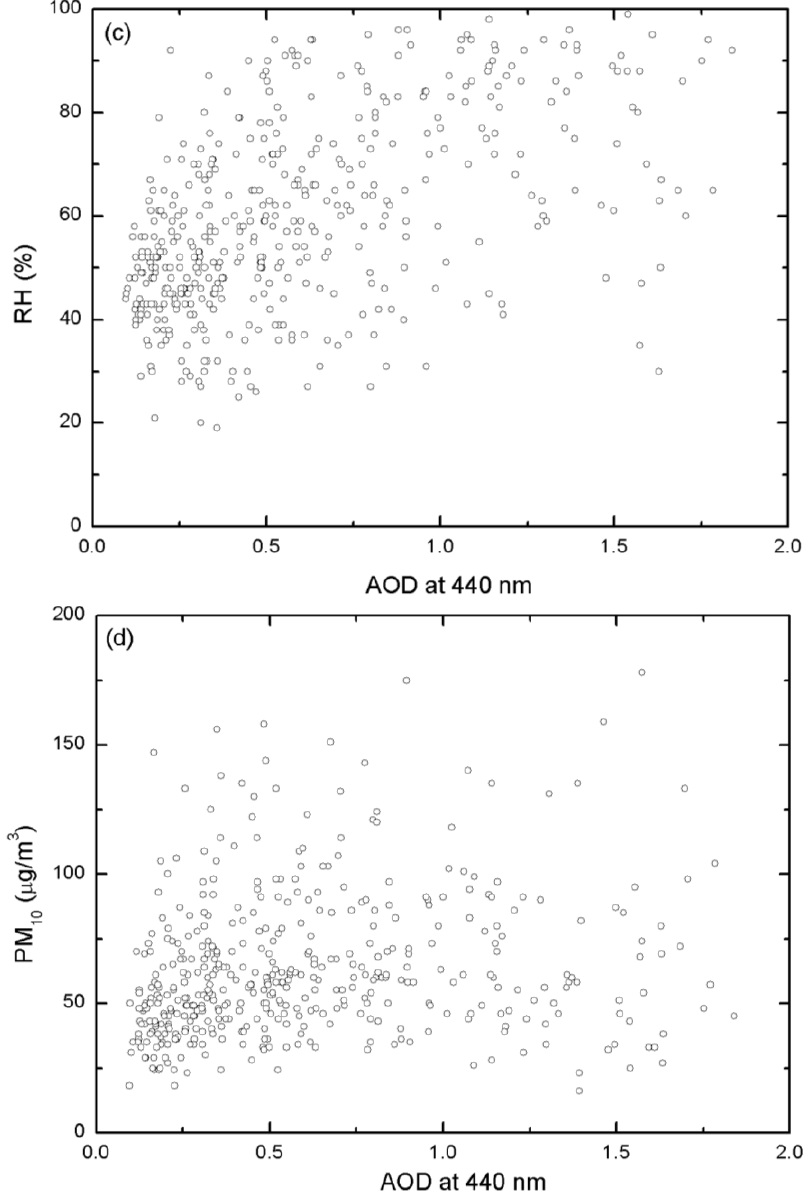
Figure 7. Scatter grams of the daily AOD and ( a ) wind speed; ( b ) temperature; ( c ) relative humidity (RH); and ( d ) PM 10 at Dalian monitoring station.